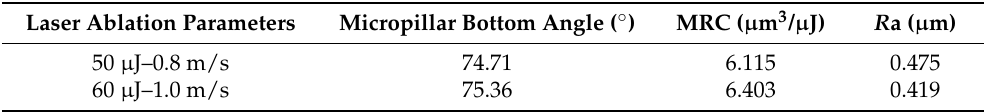
Table 2. Effect of different laser pulse energies and laser translation speeds on the micropillar bottom angle, MRC, and R a at the same micropillar height of 92 µm.